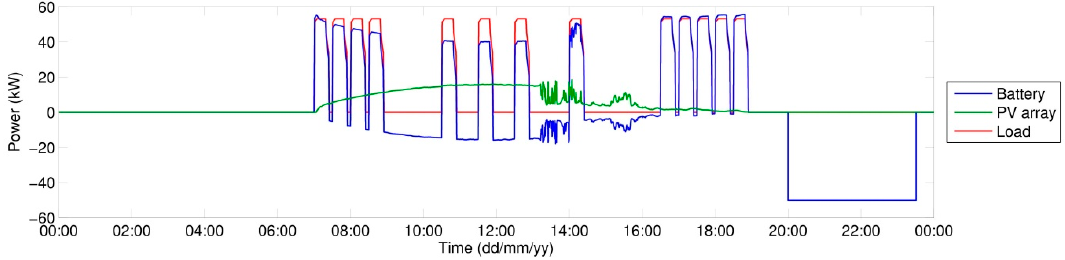
Figure 18. Power profiles in simulation of individual states, scenario A–detailed view of 4th day.